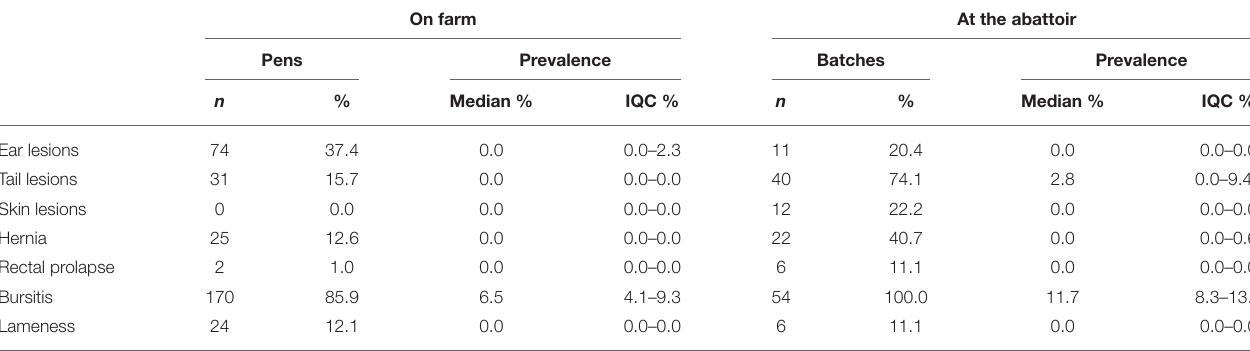
TABLE 2 | Number and percentage (%) of pens on farm (198 pens; 9,049 pigs) and batches at the abattoir (54 batches; 8,843 pigs).